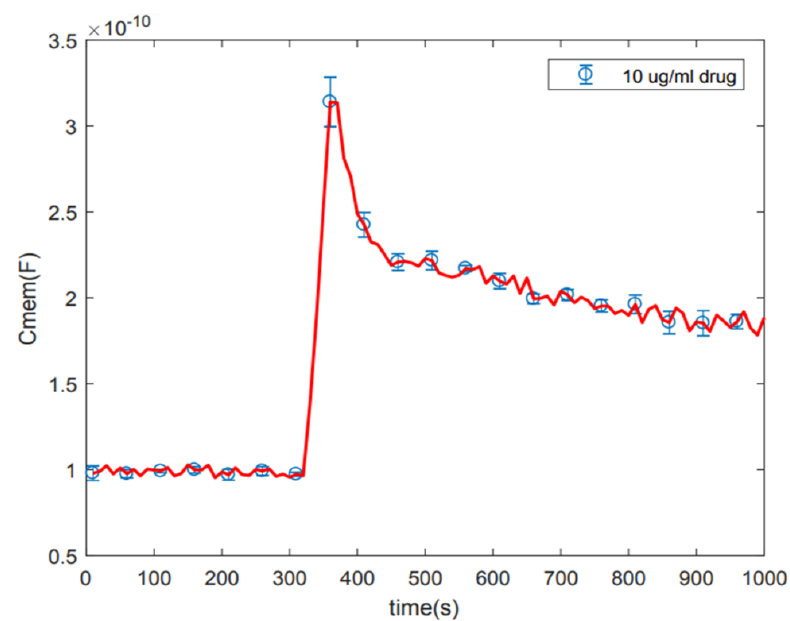
Figure 3. Standard deviation on 10 µg/mL amiodarone. The average value of three times repletion and standard deviation of the measurement for each five data points was plotted.